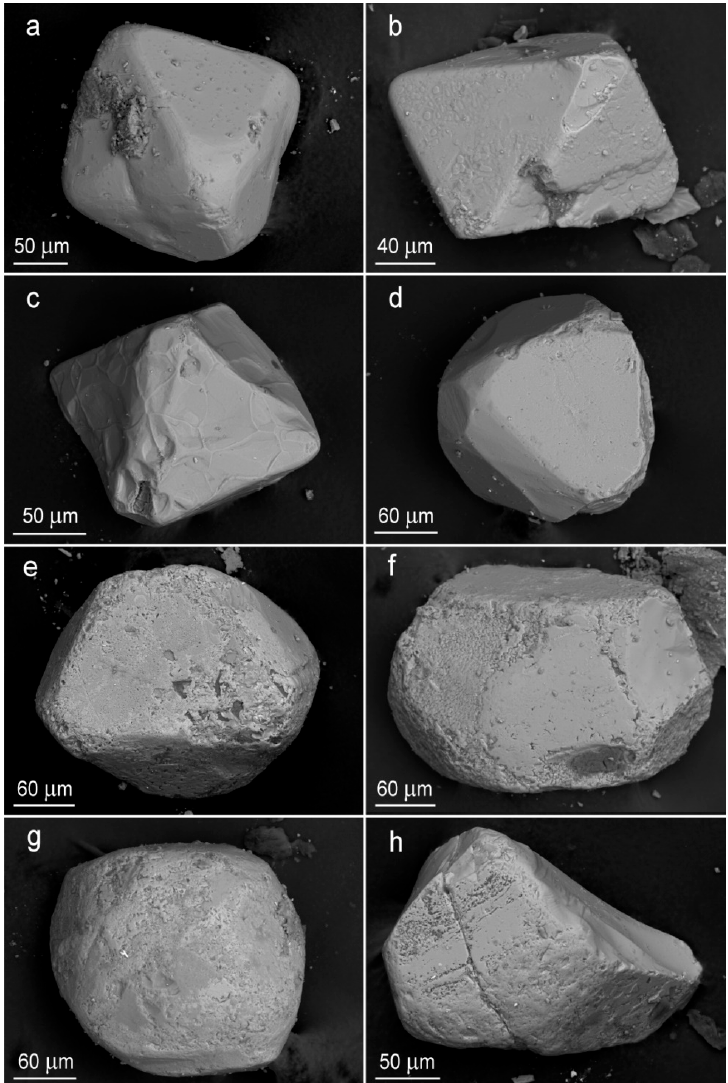
Figure 6. BSE images of chromspinel grains from chromitolites of Sabantuy paleoplacer: ( a – c ) octahedral, ( d ) octahedral with vicinal faces, ( e ) flattened octahedral, ( f ) non-octahedral (rhombodo- decahedron) corroded, ( g ) rounded non-octahedral (myrihedron) corroded and ( h ) fragments of non-octahedral crystal.